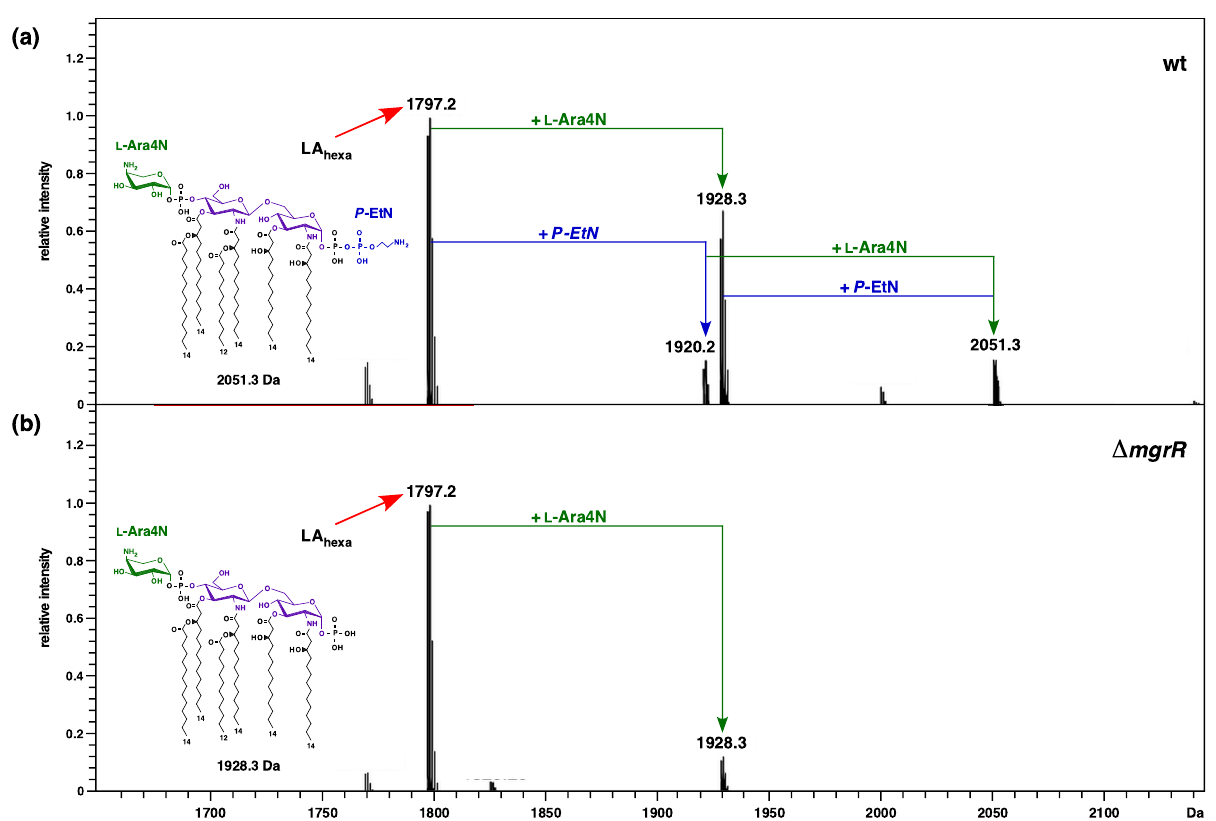
Figure 13. Δ mgrR strains do not incorporate lipid A nonstoichiometric modification by P-EtN on lipid A, even under growth conditions that induce lipid A and LPS core modifications. Charge-deconvoluted ESI FT—ICR mass spectra in negative ion mode are presented. ( a ) Mass spectra of the lipid A part of the LPS obtained from the wild-type strain grown at 37 °C in phosphate-limiting 121 medium—conditions that favor the incorporation of lipid A modifications. ( b ) Mass spectra of LPS obtained from the isogenic Δ mgrR strain, also grown at 37 °C in phosphate-limiting 121 medium. The mass numbers refer to monoisotopic peaks with the proposed composition. Only mass peaks corresponding to the lipid A part are marked, and the substitutions with P-EtN and L -Ara4N are indicated.